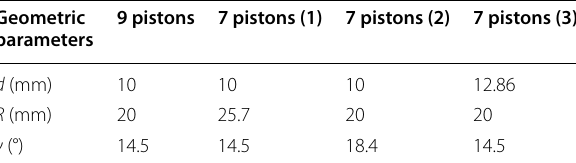
Table 3 Geometric parameters of pumps with the same displacement